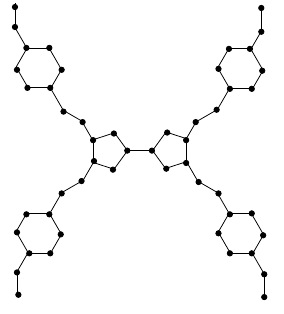
Figure 10. The core of tetrathiafulvalence dendrimer TD 2 [ 0 ] .